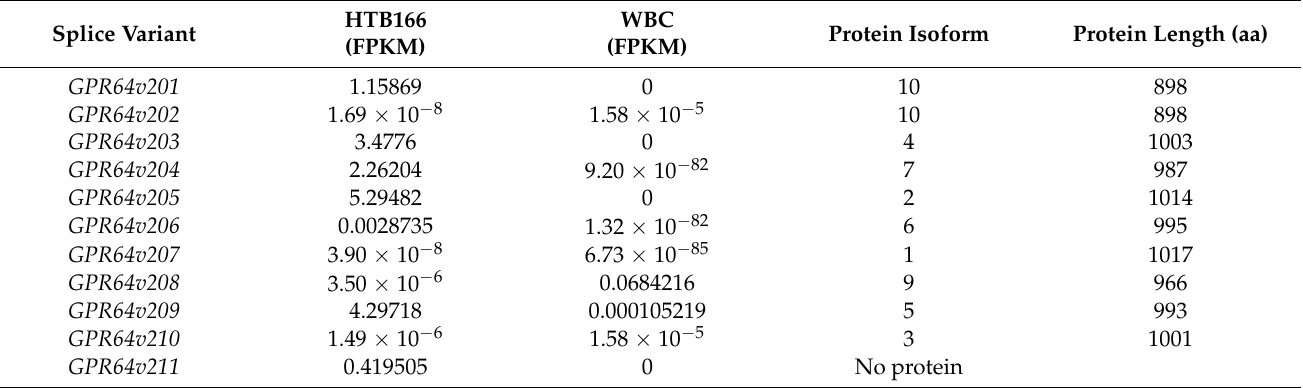
Table 1. Expression level of GPR64 splicing variants in HTB166 cells. GPR64v205 expression is upregulated the most among all GPR64 splice variants. GPR64v205 is translated into GPR64 isoform 2.